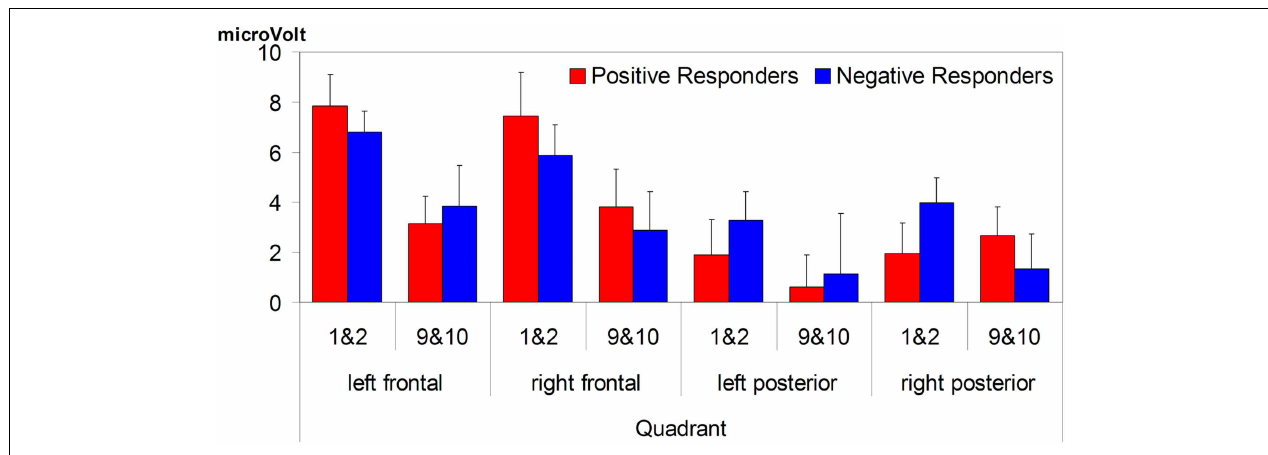
FIGURE 4 | Both groups show a similar decrease in positive amplitude for familiarized words in isolation (presented 9 & 10 times), compared to the first two times. For both groups, the decrease was most pronounced over frontal quadrants of the brain.